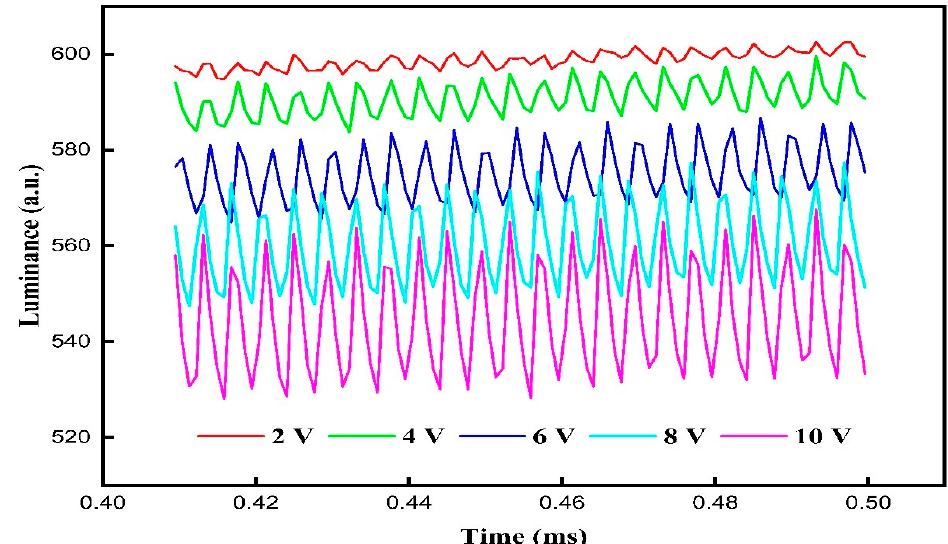
Figure 7. Luminance curves driven by different voltage amplitudes of the driving stage in the proposed driving waveform. The amplitude of luminance oscillation could be increased with the increase in voltage amplitudes. The minimum amplitude of luminance oscillation was 4.1 when the voltage amplitude was 2 V. In addition, the average luminance could be decreased with the increase in the voltage amplitude. The maximum average luminance was 598.79 when the voltage amplitude was 2 V.